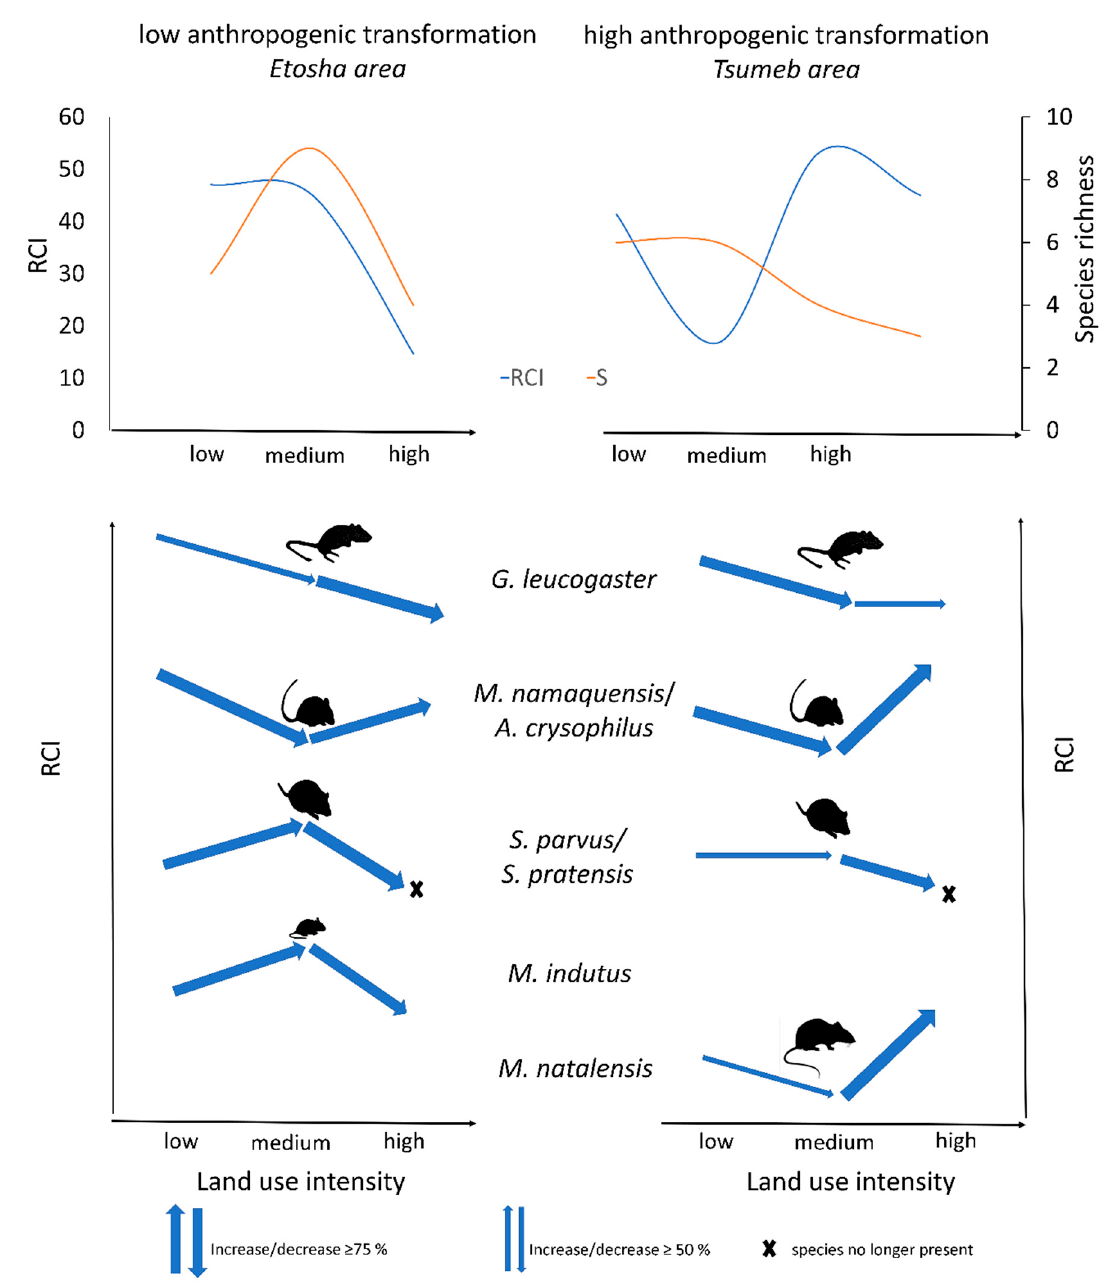
Figure 4. Relationship between ecological parameters (total values of RCI and S) and schematic representation of response patterns of different small mammal species along gradients of land use intensity (low, medium, high) in the two study areas with different degrees of anthropogenic transformation (Etosha area, Tsumeb area).